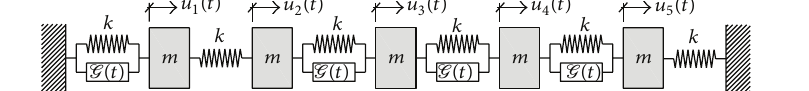
Hence, the set of eigenvalues can be obtained from the following 𝑛 decoupled